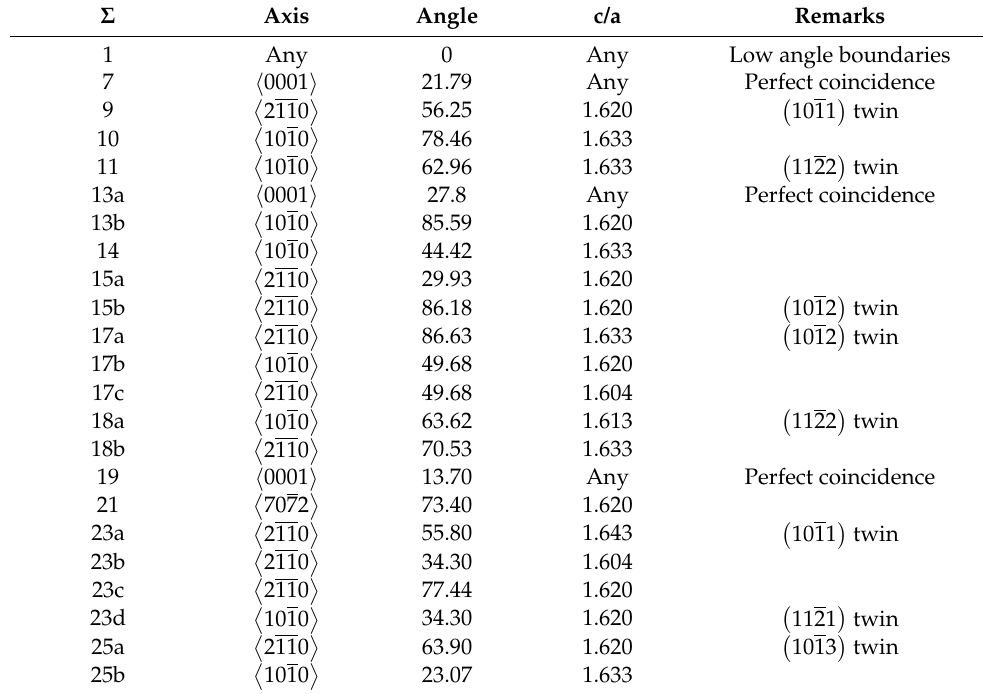
Table 4. Possible near-CSL grain boundaries in magnesium